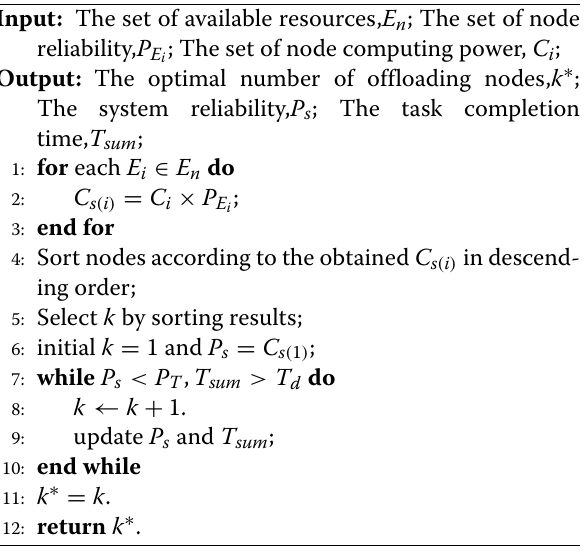
Algorithm 1 The offloading algorithm based on partial